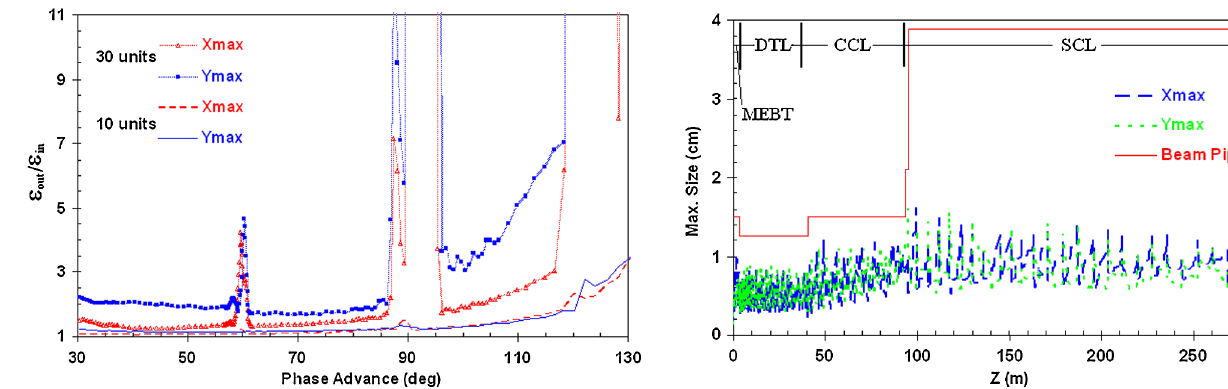
FIG. 5. (Color) Maximum beam size in PARMILA simulation versus the linac aperture, for a 38 mA design injection beam and the baseline linac design lattice without dodecapole.